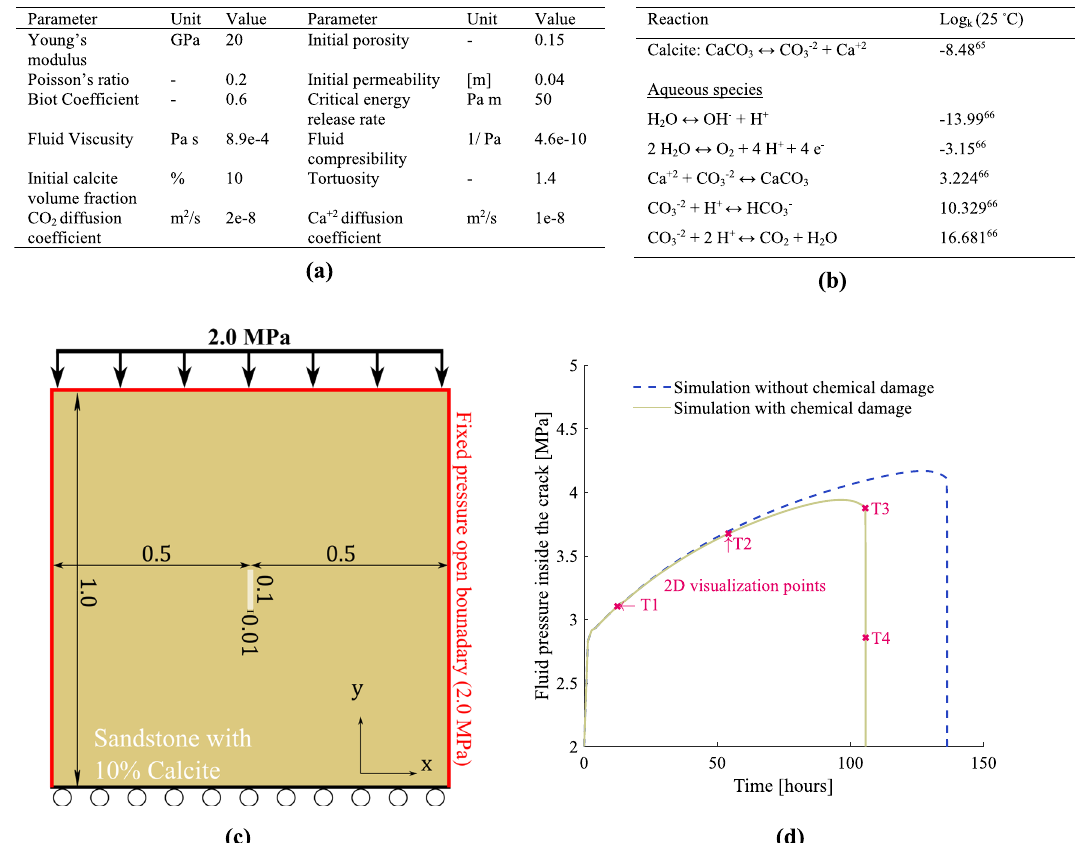
Figure 6. ( a ) Material and model parameters for carbonate water injection into carbonate-rich sandstone case. ( b ) Reactions involved in the equilibrium and speciation calculations solved in PHREEQC. ( c ) Schematic of the simulation domain, including initial fracture and boundary conditions for the carbonated water injection into sandstone with 10% calcite. ( d ) Calculated pore pressure versus time for different cases with and without chemical interactions, highlighting the importance of chemical